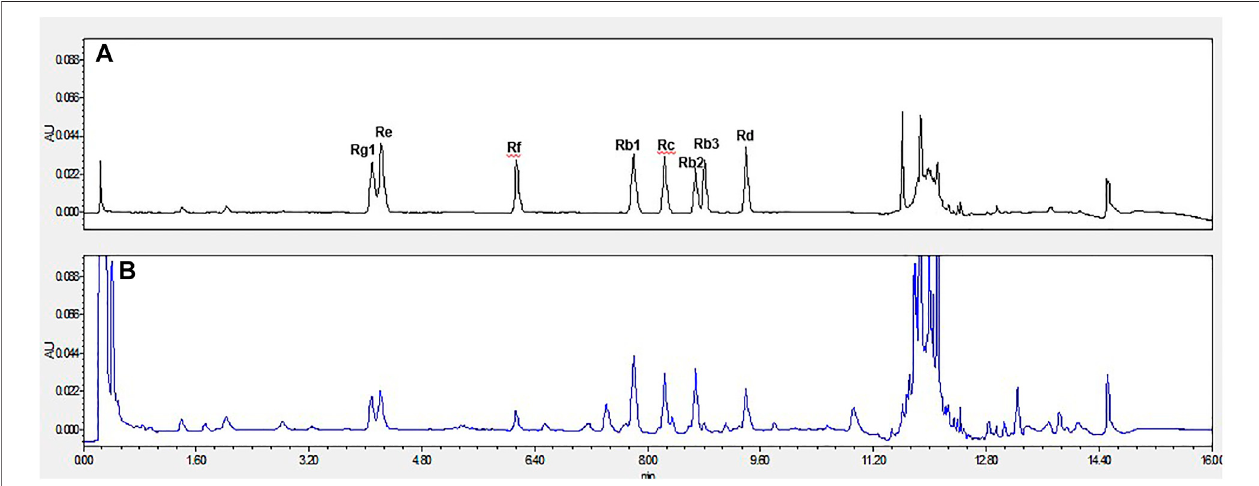
FIGURE1| TherepresentativeUPLCchromatogramsofginsenosides. (A) .ThereferencestandardsofginsenosidesRg1,Re,Rf,Rb1,Rc,Rb2,Rb3,Rd. (B) .Red ginseng sample.; Abbreviation: UPLC, Ultra Performance Liquid Chromatography.